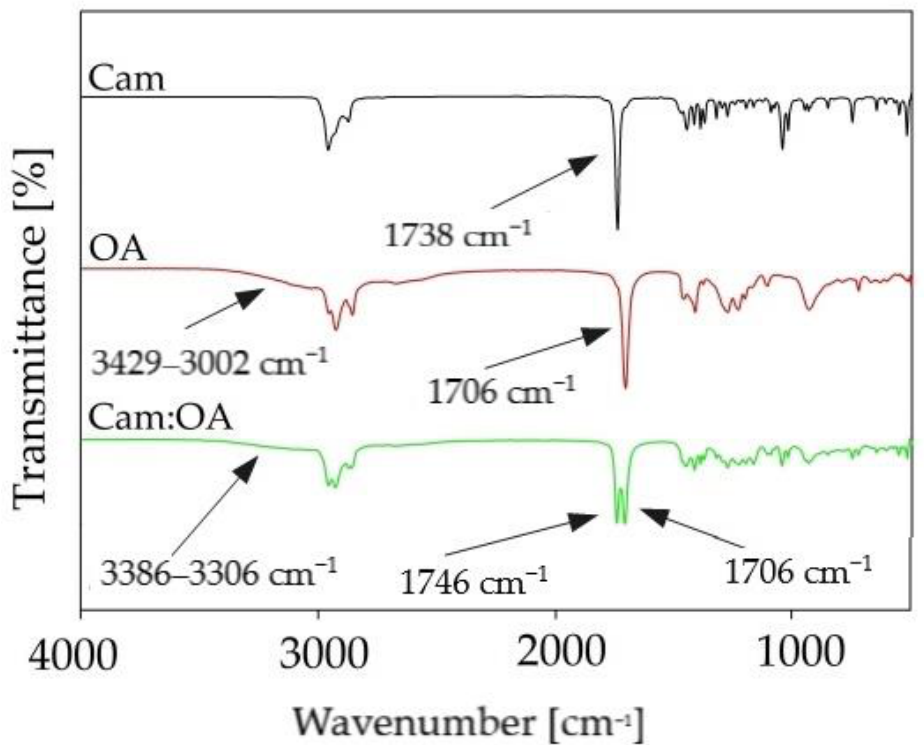
Figure 7. FT-IR spectra of pure components (Cam and OA) and prepared Cam: OA (1:1). In addition, to confirm the chemical structure of the newly prepared DES based on Cam: OA (1: 1) 1 H NMR and 13 C NMR, analyses were performed (Figure 8). In the 1 H NMR spectrum, the shifts in signals from the protons Cam and OA can be observed. The strongest hydrogen shifts are observed for 1-H from the carboxyl group derived from organic acid OA (from 11.6 ppm to 11.25 ppm) and for both hydrogen 1-H (from 2.36 ppm to 2.29 ppm) and 2-H (from 2.09 ppm to 1.99 ppm), which are derived from the Cam phenolic ring. There are no extra peaks observed in the spectrum, which confirms the absence of by-products during DES preparation. The conducted 13 C NMR spectra analysis produced similar